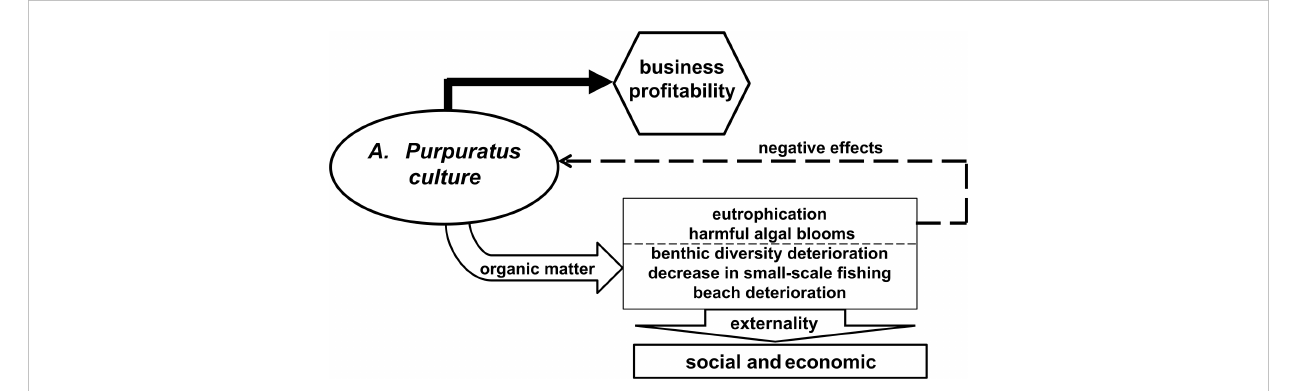
FIGURE 2 Traditional marine culture model in Samanco